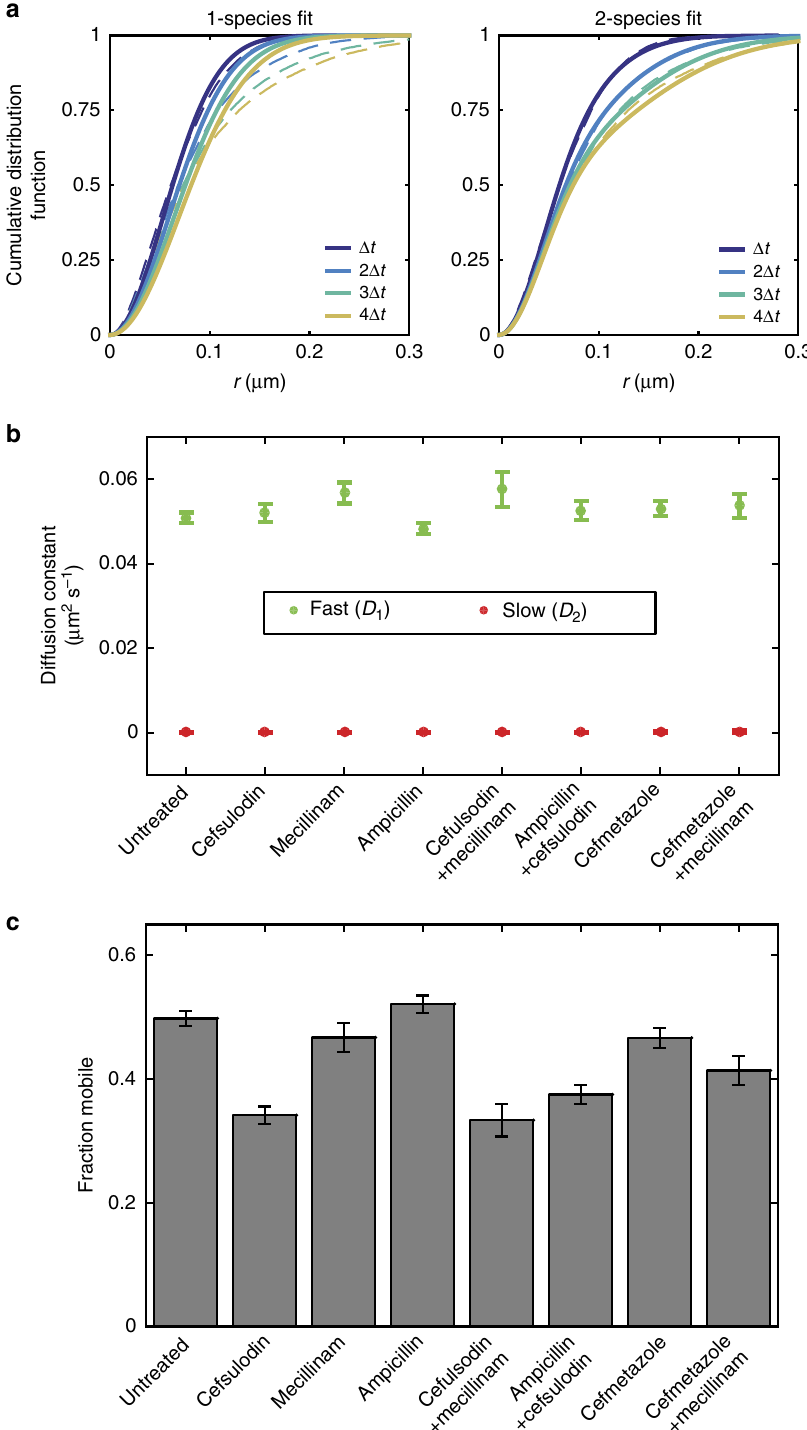
Figure 4 | Relative PBP1A mobility can be explained by a shift in the mobile fraction. ( a ) The cumulative distribution function (dotted lines) of step sizes ( r ) for PBP1A molecules ( n ¼ 3,177 molecules, TKL241) was calculated for D t of 1, 2, 3, or 4 frames (30, 60, 90, or 120ms, respectively). These four distributions were simultaneously fit to models with a single species (left) or with two diffusing species (right). Model equations are given in the Methods. ( b ) The fits with two diffusing species resulted in a fast diffusion constant and a slow diffusion constant that was indistinguishable from localization error. ( c ) The fraction of mobile molecules (governed by the fast diffusion constant, D 1 ) mimics the effective diffusion constant fitted from the MSD. In b and c , error bars indicate the s.d. of 1000 bootstrap